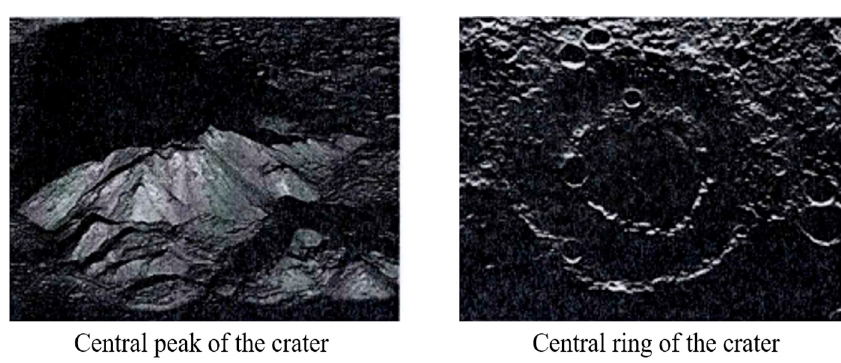
Figure 10. Central peak shapes (from NASA, [52]).